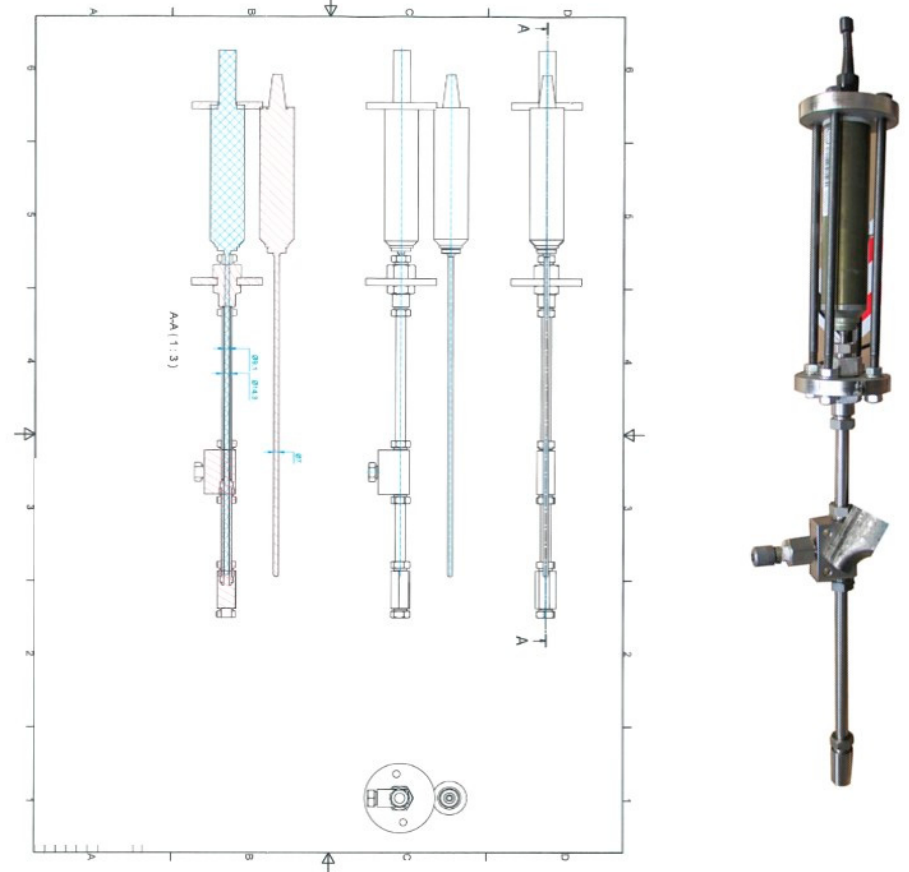
Figure 6. Technical drawing (left) and CAD image of the realized pressure enclosure for the SBE35.